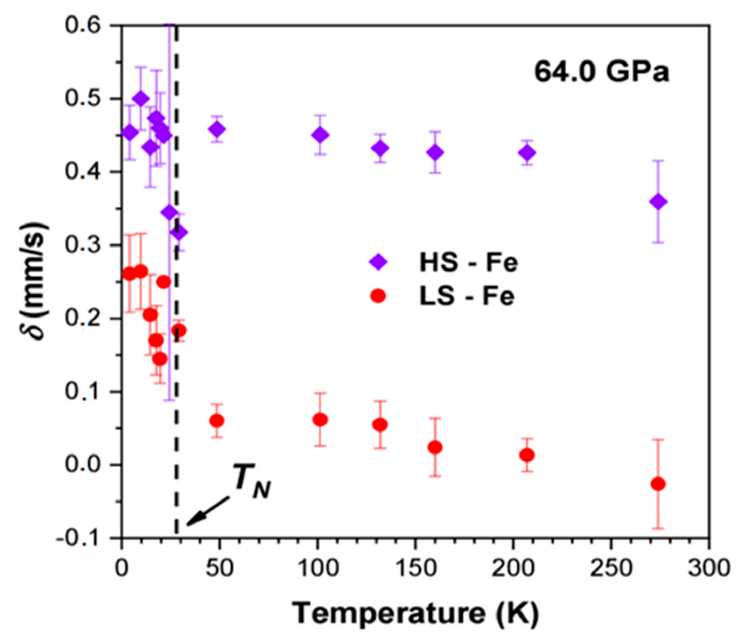
Figure 11. (Colour on-line) Temperature dependences of isomer shift values for HS and LS fractions of iron ions in Ba 3 NbFe 3 Si 2 O 14 obtained from Mössbauer spectra at a pressure of 64.0 GPa. The vertical dashed line corresponds to the point of magnetic collapse (Neel temperature).